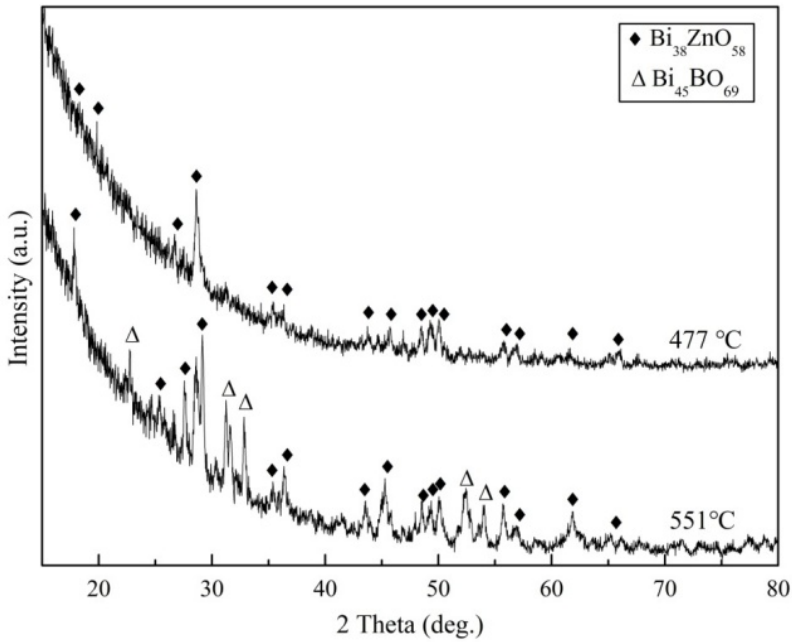
Figure 2. XRD patterns of the glass powders heat treated at 477 and 551 °C for 20 min.